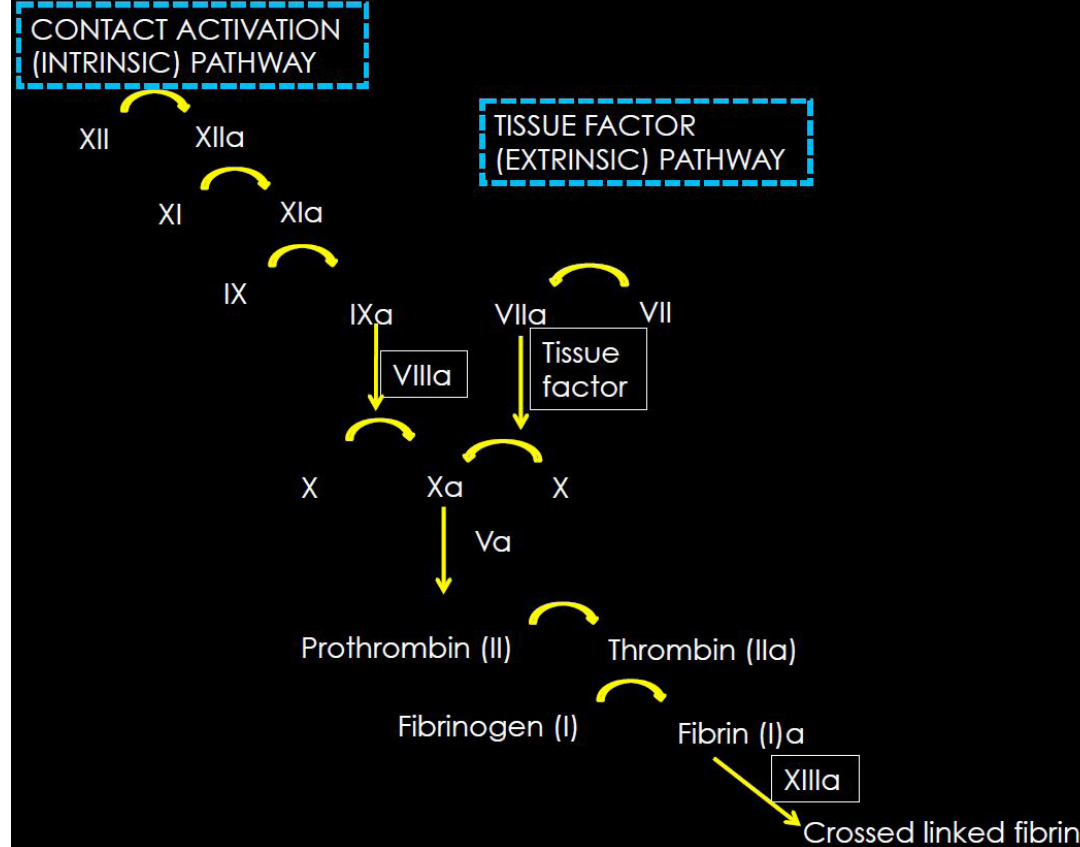
Figure 1. The coagulation cascade.